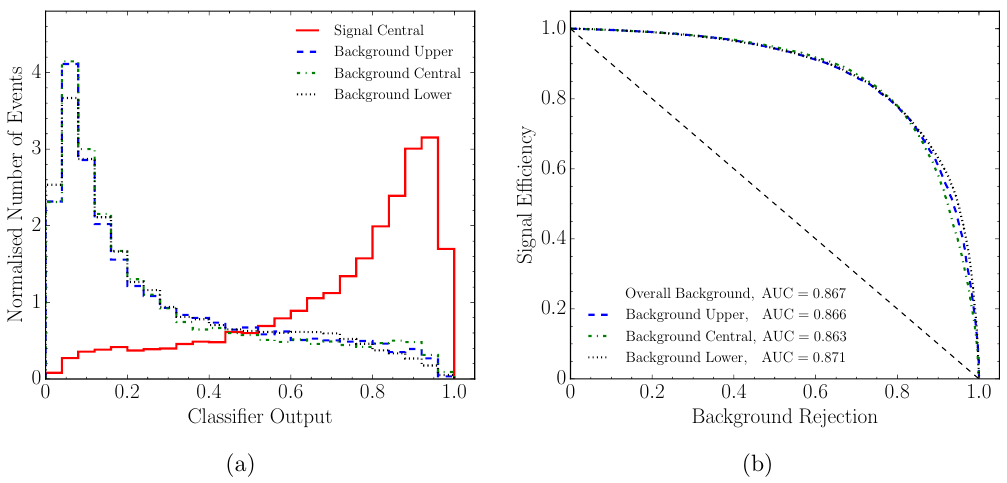
Figure 3. Supervised neural network classi(cid:12)er output (a) and ROC curves (b) for an adversarial classi(cid:12)er trained to classify signal and background events. The three background distributions result from the three di(cid:11)erent directions of smearing.